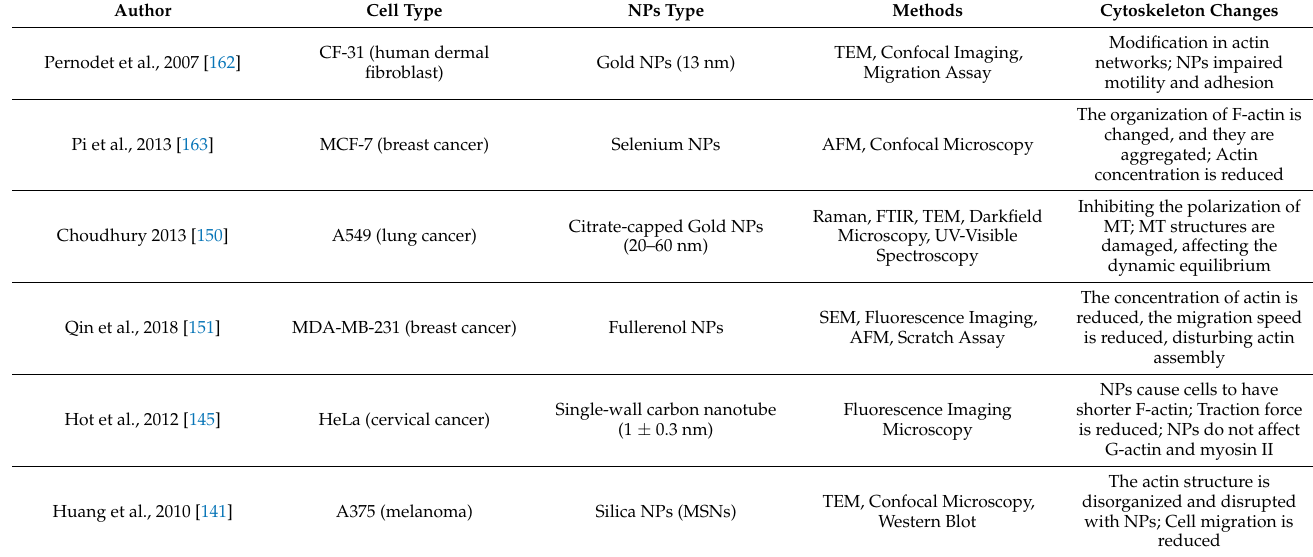
Table 2. Cytoskeletal changes due to the NPs–protein